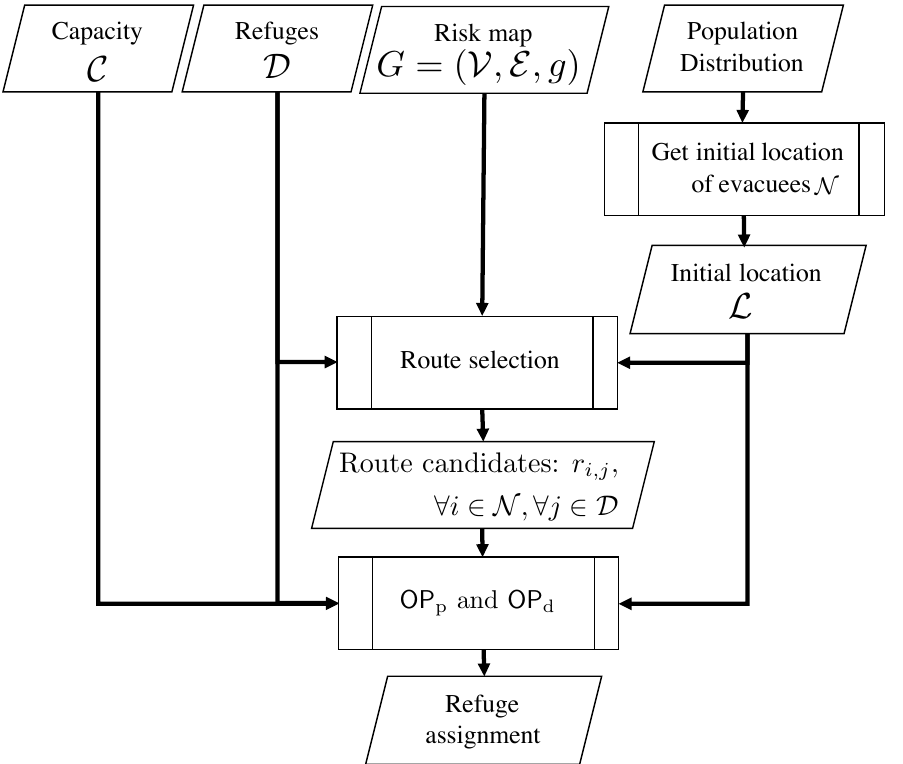
Figure 1. Flow chart of calculating the refuge assignment and the route